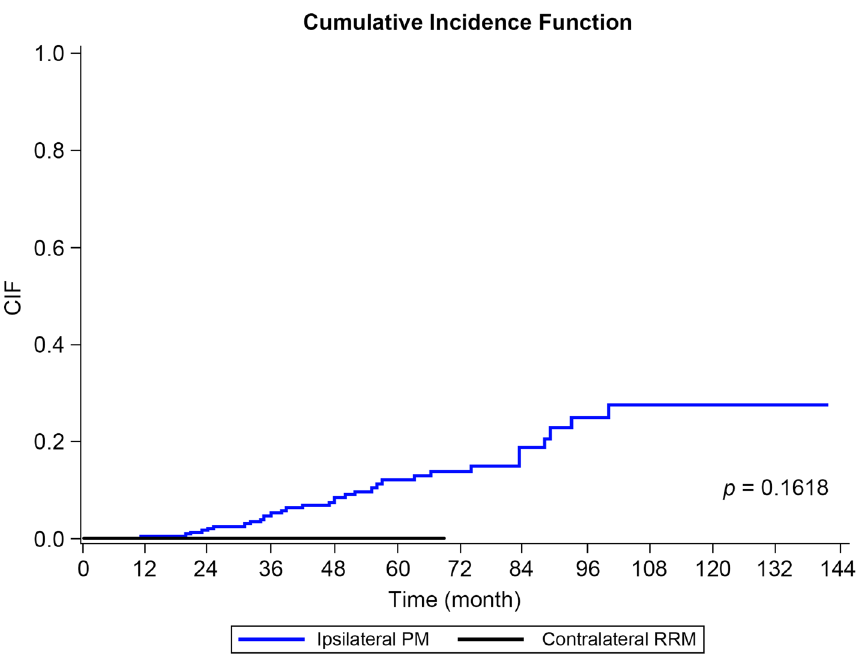
Figure 2. Cumulative incidence function plot of contralateral breast cancer according to types of surgery. PM partial mastectomy, RRM risk reducing